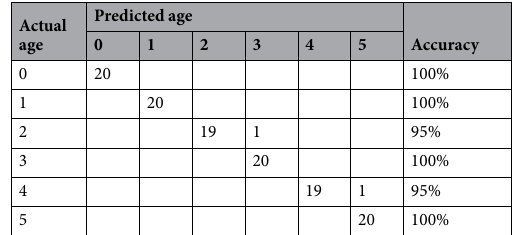
Table 3. Classification results of six age groups based on LDA. The total accuracy of the 120 samples is 98.3%.